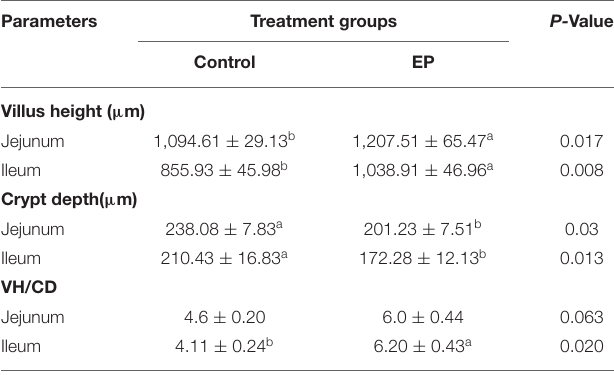
TABLE 4 | Effects of EP polysaccharide supplementation on the intestinal morphology of broiler chickens. Parameters Treatment